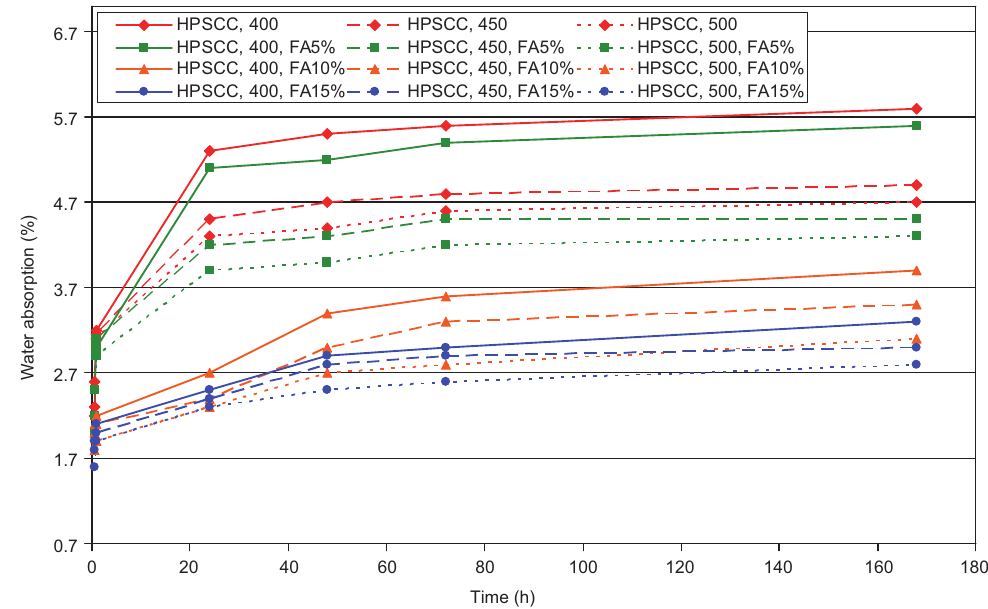
Figure 8 Water absorption vs. time for mixtures with different cement contents and fly ash